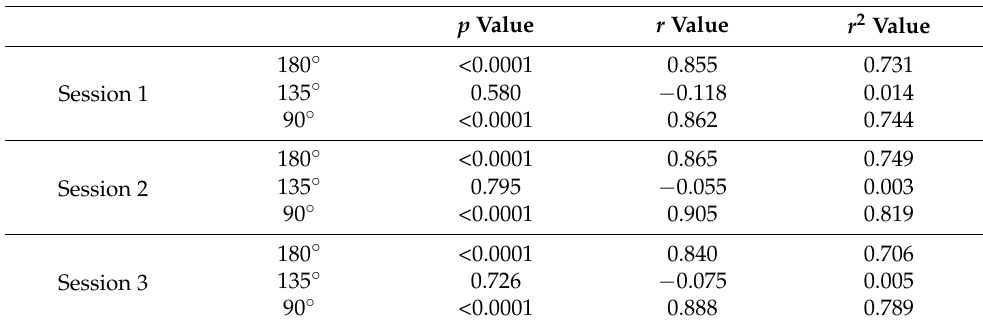
Table 6. Correlation between ASH test results using Active5™ and K-Force plates in the nondominant upper limb in the female